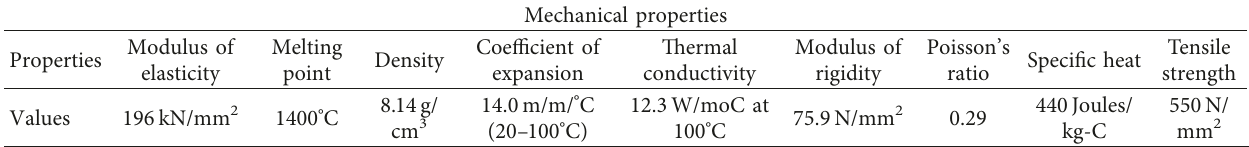
Table 2: Mechanical properties of Inconel 825.